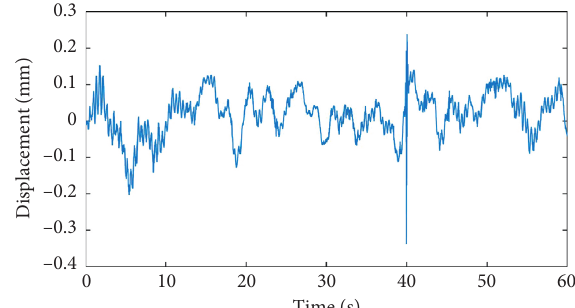
Figure 7: The waveform of the dynamic deflection of the Fengbei Bridge by